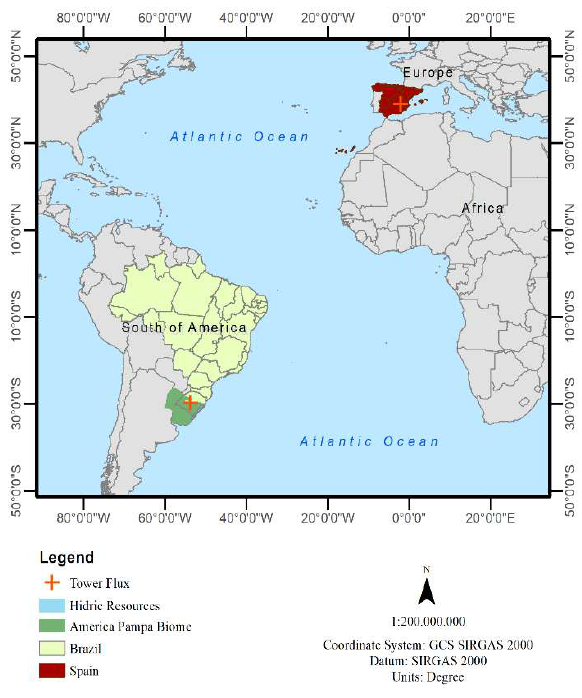
Figure 1. Experimental site locations in Pampa Biome (Brazil) and Barrax (Spain) site